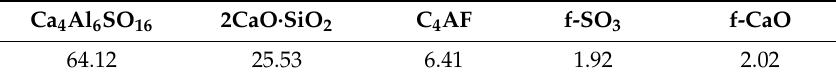
Table 2. Mineral composition of CSA clinker (wt.%).